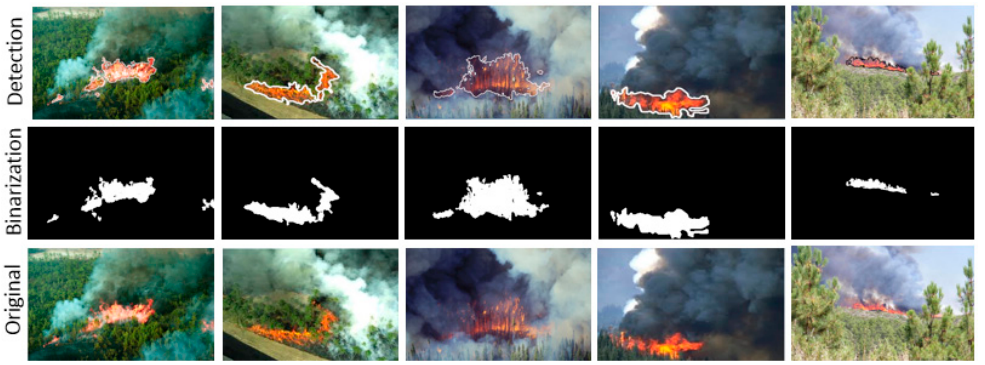
Figure 6. Examples for forest fire detections from aerial perspective.